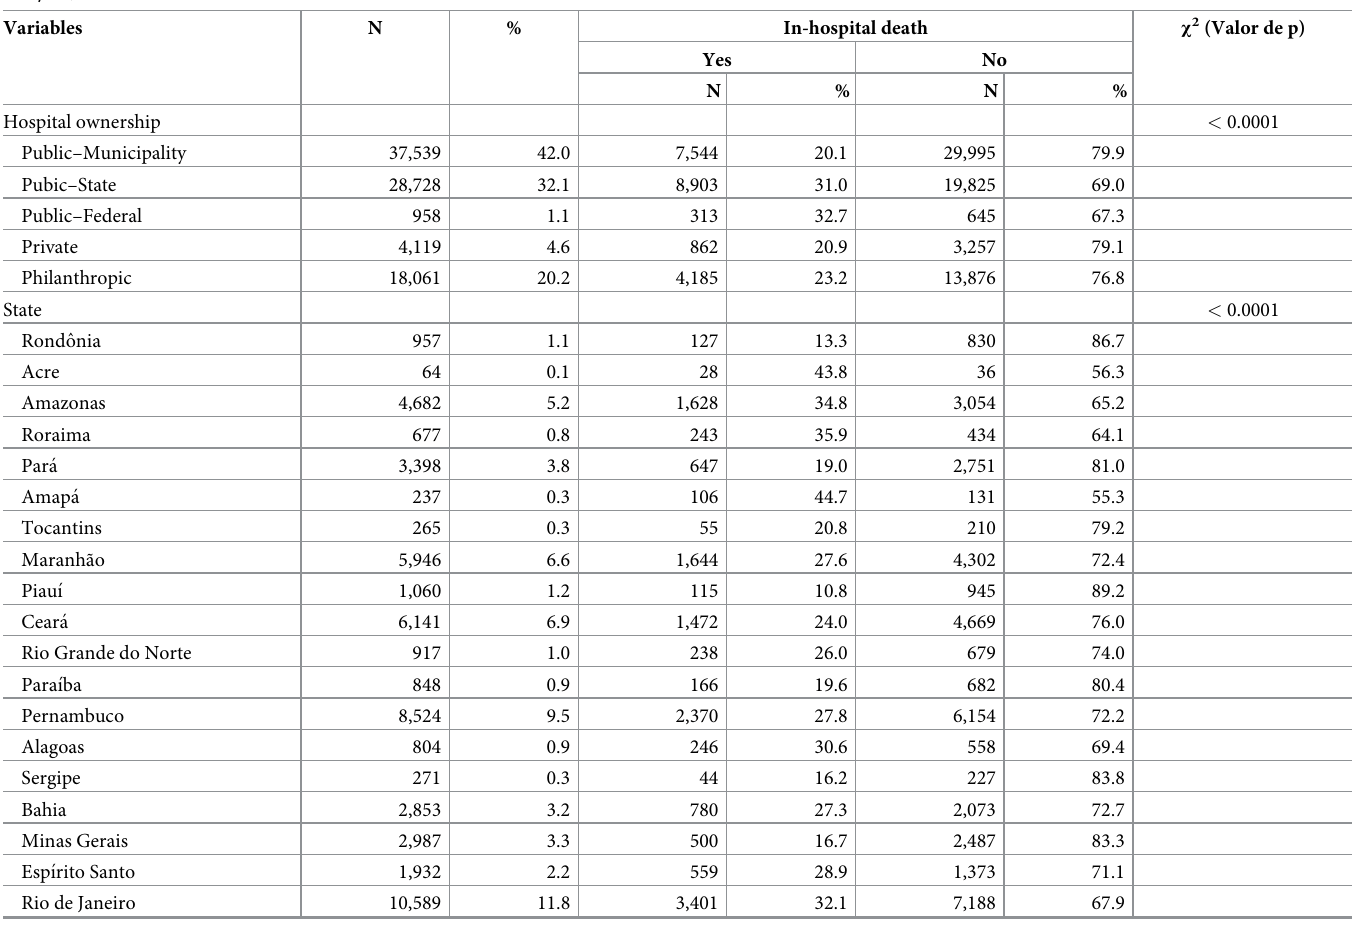
Table 3. Bivariate analyses of macro context variables and in-hospital mortality. COVID-19 hospitalizations in the Unified Health System in Brazil (N = 89,405). Feb- ruary to June 2020.